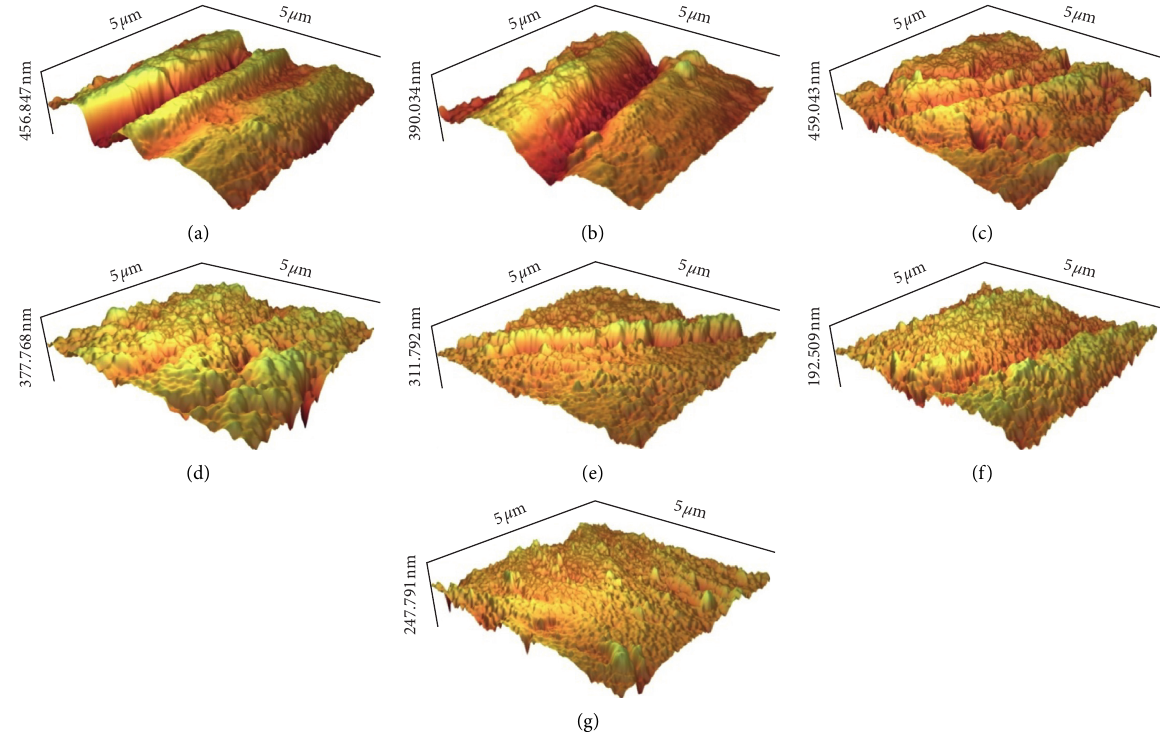
Figure 3: Atomic force microscopy image of enamel surface in groups after surface treatment and erosive challenge: (a) CAP +Enamelast, (b) CAP +FluoroDose varnish, (c) CAP application, (d) Erosion, (e) Control, (f) Enamelast varnish, and (g) FluoroDose